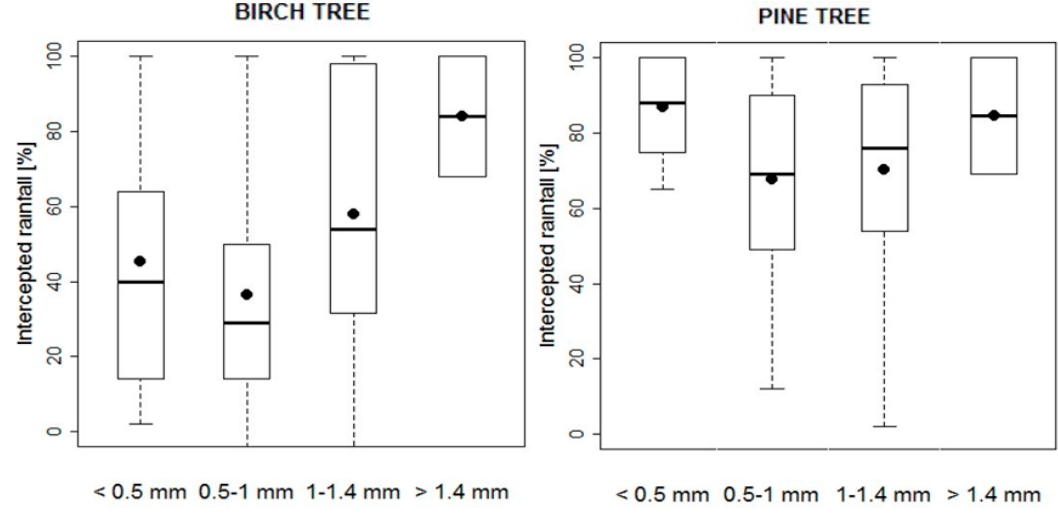
Figure 4. Box plots of rainfall interception according to average event’s drop diameter